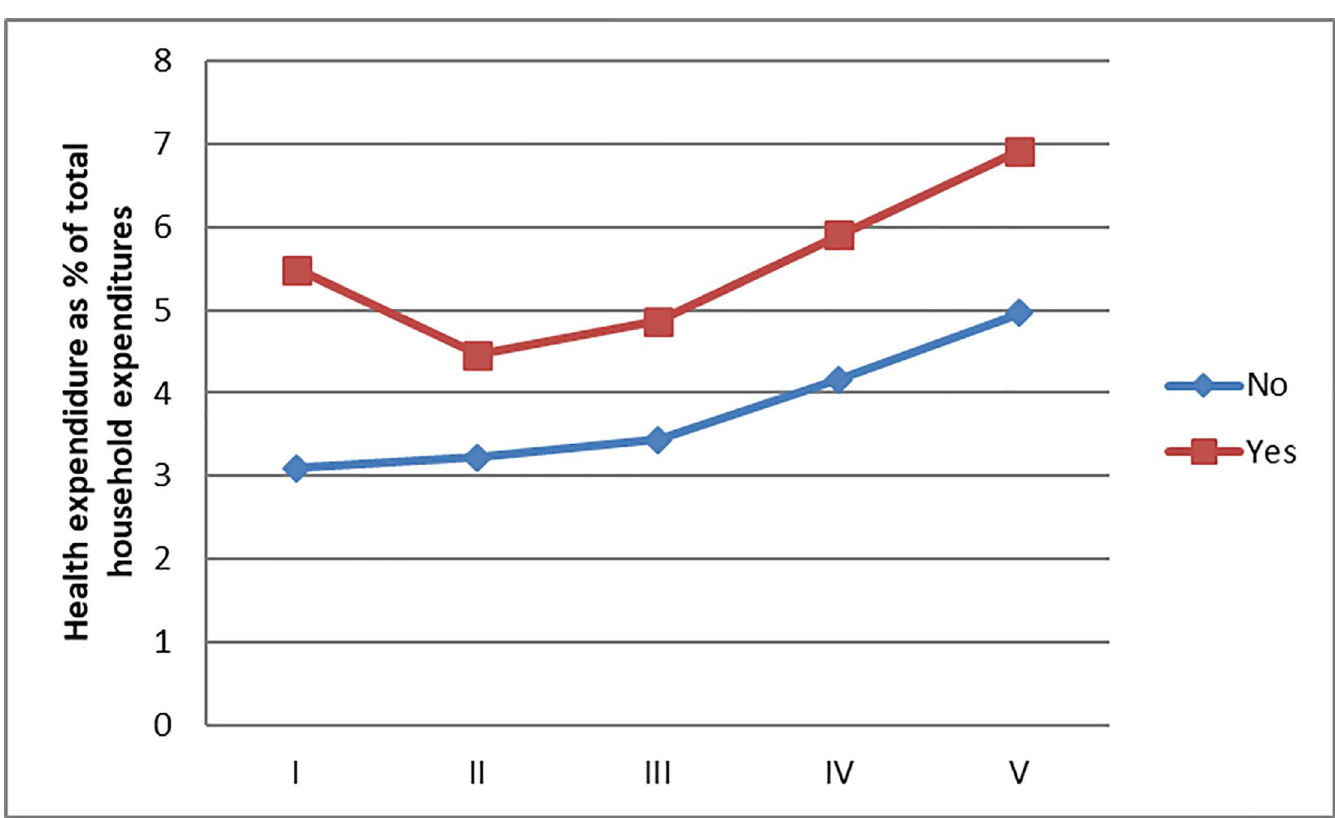
Fig 1. Mexican household health expenditure as proportion of total expenditure according to presence of a member with diagnosed diabetes or